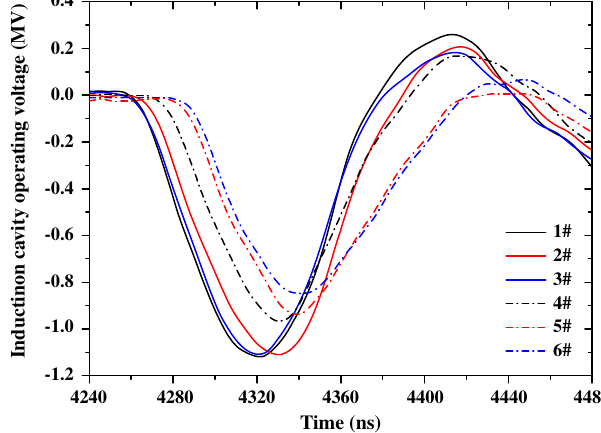
FIG. 10. Voltage waveforms of the PFL (solid line) and WTL (dashed line). The PFL voltage was obtained by a D-dot probe at the middle of this component while the voltage pulse on WTL was monitored by another D-dot sensor at the front of this element.